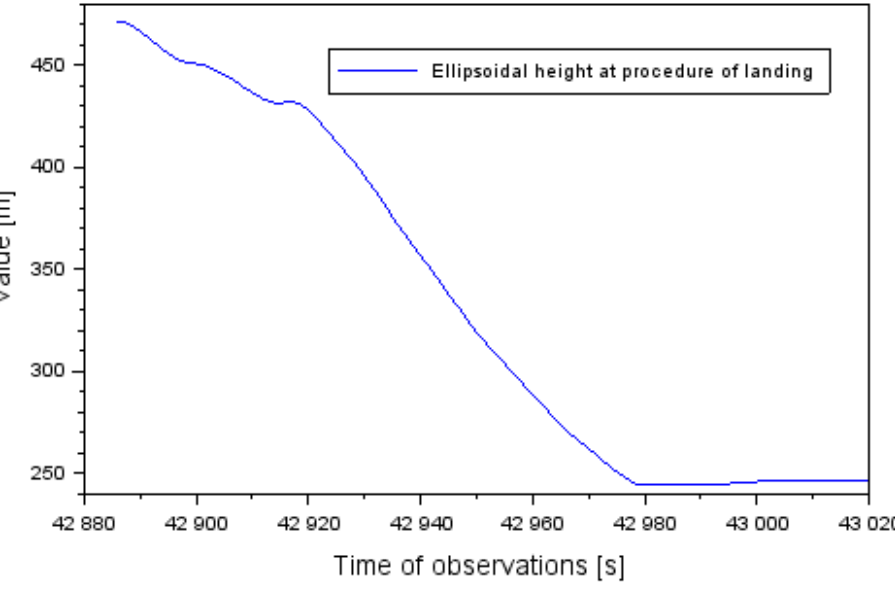
Figure 5. Vertical profile of the Cessna 172 during the landing process at Chełm airport.